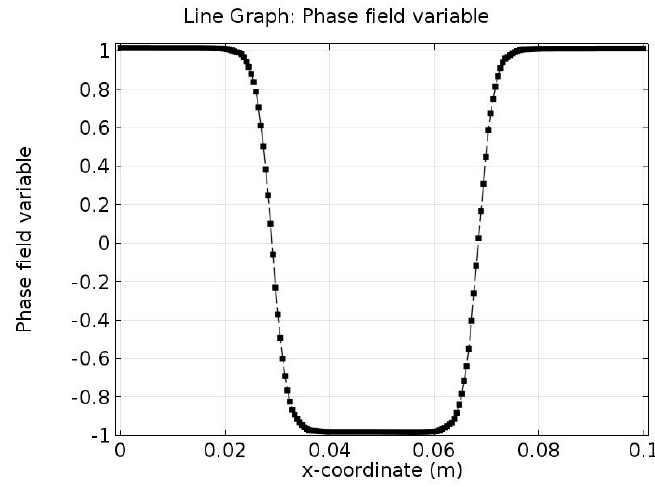
Figure 11. Phase field variable distribution at the bottom boundary at t = 0.5 s.